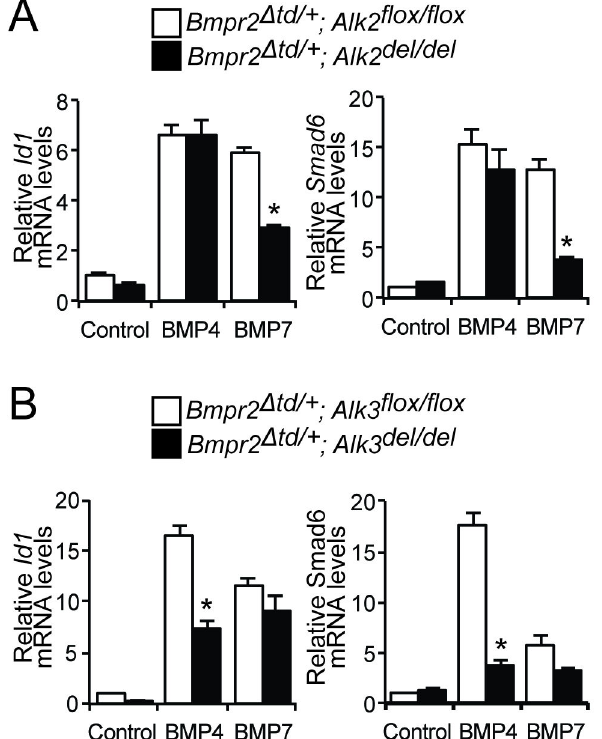
Figure 5. BMP7 preferentially utilizes Alk2 in Bmpr2 Δtd/+ PaSMCs. (A) The ability of BMP4 or BMP7 (10 ng/ml for 1.5 h) to induce Id1 and Smad6 gene expression, in Bmpr2 Δtd/+ PaSMCs deficient in Alk2 or expressing Alk2 was examined by qPCR. Id1 and Smad6 gene expression was normalized to Gapdh and expressed as fold-change relative to Bmpr2 Δtd/+ ; Alk2 flox/flox PaSMCs. *P < 0.01 compared to Bmpr2 Δtd/+ ; Alk2 flox/flox PaSMCs treated with BMP7. (B) The ability of BMP4 or BMP7 (10 ng/ml for 1.5 h) to induce Id1 and Smad6 gene expression, in Bmpr2 Δtd/+ PaSMCs deficient in Alk3 or expressing Alk3 was measured by qPCR. Id1 and Smad6 gene expression was normalized to Gapdh and expressed as fold-change relative to Bmpr2 Δtd/+ ; Alk3 flox/flox PaSMCs. *P < 0.01 compared to Bmpr2 Δtd/+ ; Alk3 flox/flox PaSMC treated with BMP4. doi: